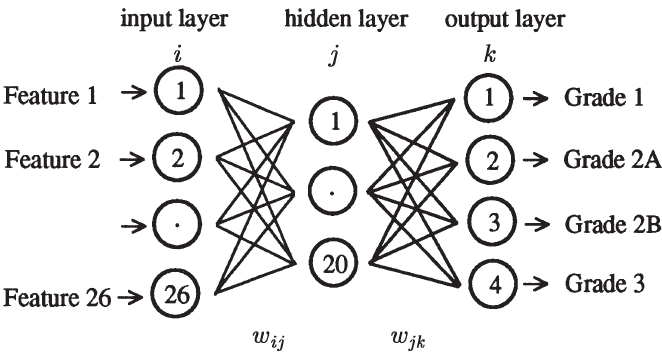
Fig. 6. Schematic diagram for a back propagation neural network. The w ij was the weight from applied neuron i to j . The input layer consisted of 26 features. Each of these was connected to the hidden layer of 20 neurons, which was in turn connected to the output, and which was representative for the four-grading